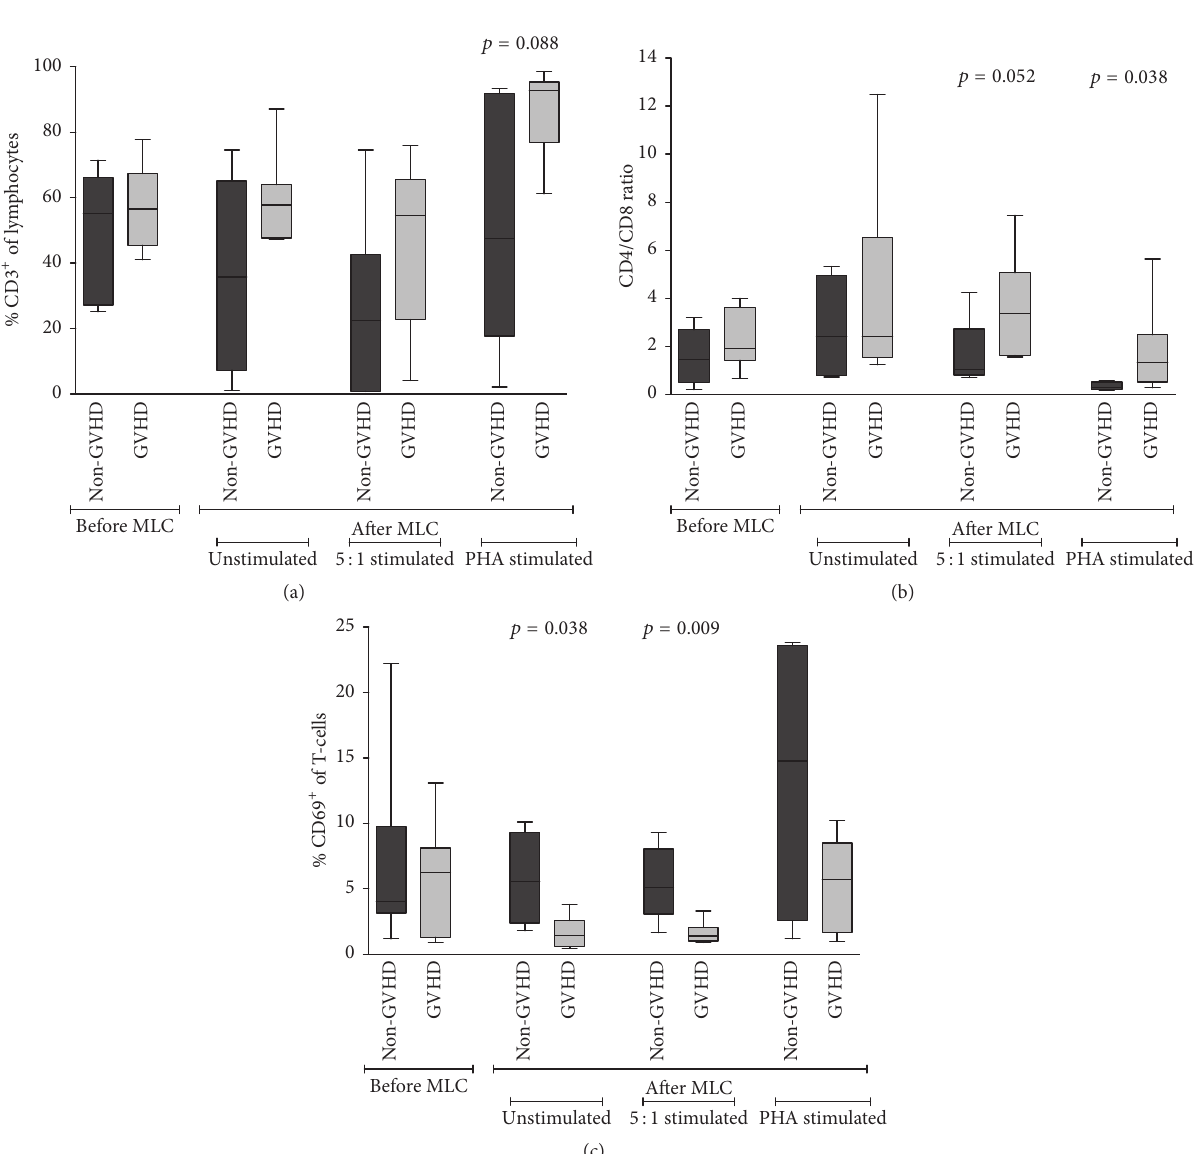
Figure 3: The GVHD group showed dissimilarity in CD4/CD8 T-cell ratios and frequencies of CD69 + T-cells when responding donor cells were analysed after MLC. Flow cytometric analysis of responder cells (of donor origin) before and after MLC. Statistical analysis was done with the Mann–Whitney 𝑈 test. (a) Frequencies of T-cells before and after MLC. T-cell frequencies did not differ between the non-GVHD and GVHD groups. (b) CD4/CD8 T-cell ratios before and after MLC. The CD4/CD8 T-cell ratio was similar between the two patient groups before MLC. After MLC, the CD4/CD8 ratio shifted towards an increase of CD4 + T-cells and a decrease of CD8 + T-cells in the GVHD group. (c) Frequencies of CD69 + T-cells before and after MLC. CD69 was expressed more on T-cells of non-GVHD patients after MLC for the unstimulated and 5 :1 stimulated